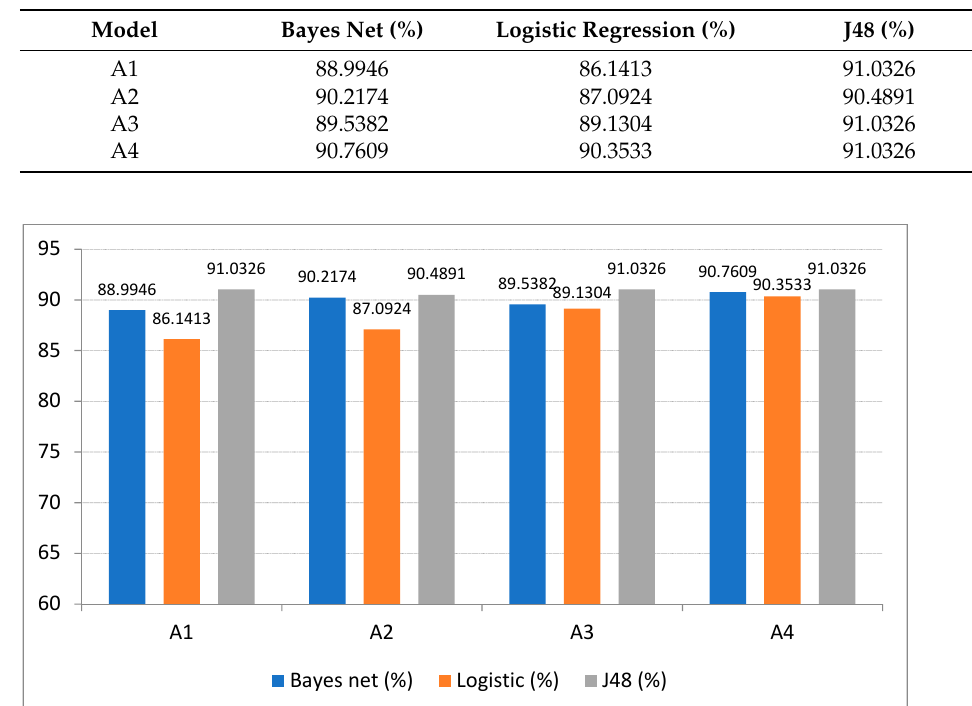
Table 6. Models A1-A4 net profit decision (comparison table).